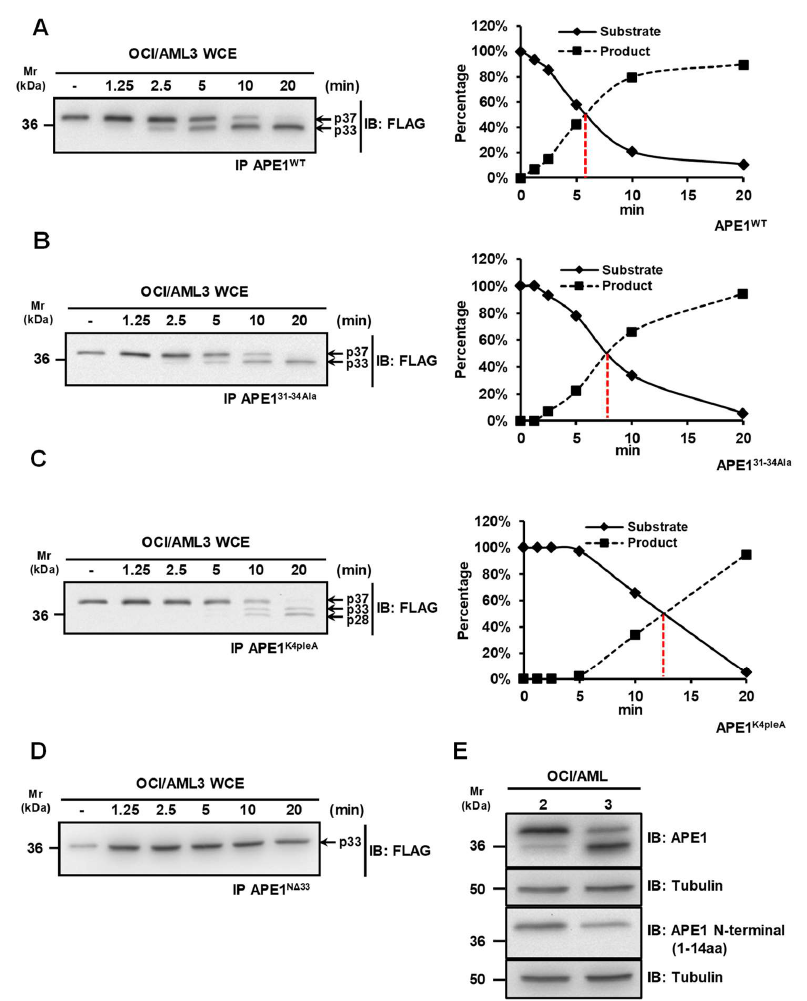
Figure 1 . A protease activity is responsible for the cleavage of the APE1 N-terminal domain. ( A – D ) Kinetic measurements for the protease activity towards different APE1 mutants. Whole OCI/AML3 cell extracts (10 µg) were incubated for the indicated times, at 37 °C, with immunopurified FLAG- tagged APE1 recombinant proteins expressed in HeLa cells in the wild-type form (APE1 WT ) ( A ), the APE1 31-34Ala form where residues 31-34 were mutated to Ala ( B ), the APE1 K4pleA form where Lys27, Lys31, Lys32 and Lys35 were mutated to Ala ( C ), and the APE1 NΔ33 form lacking 33 amino acids at protein N-terminus ( D ). Reactions were separated onto 12% SDS-PAGE, immunoblotted and analyzed using an antibody specific for the FLAG-tag. A representative Western blotting analysis shows the cleavage of APE1 at different times. In the diagrams on the right, the quantification of the densitometric signals of the non-cleaved form of APE1 (S) and the truncated form (P) is reported. (E) The N-terminal domain of APE1 is truncated in OCI/AML3 cells. Representative Western blotting analysis on OCI/AML 2 and 3 whole cell extracts (10 µg), showing the N-terminal truncation of APE1 in OCI/AML3 cells. Antibodies used are indicated on the right-hand side. Tubulin was used as loading control.